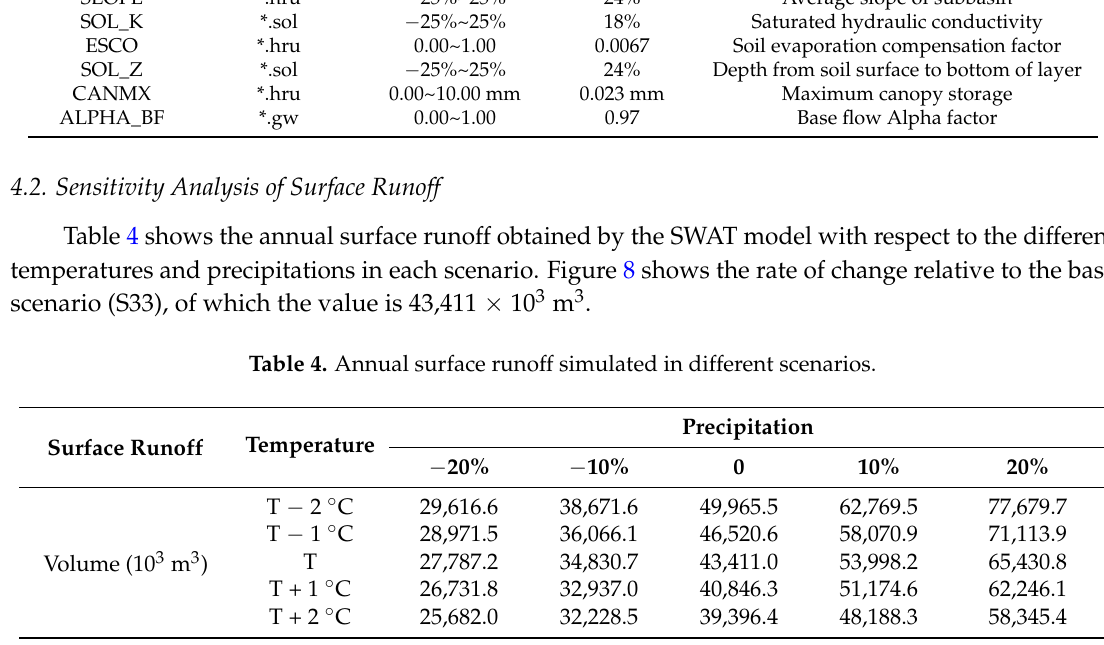
Figure 7. Observed and simulated monthly average streamflows at Shangjingyou Station.